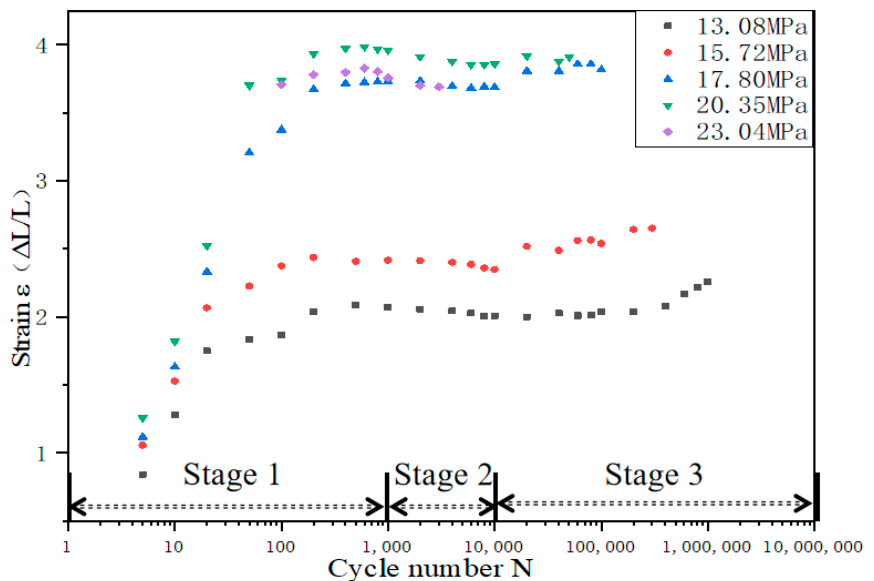
Figure 6. Strain elongation with loading cycle accumulation under various initial stresses. Δ L is the elongation of the axial length in the deformed region. The frequency was 5 Hz.